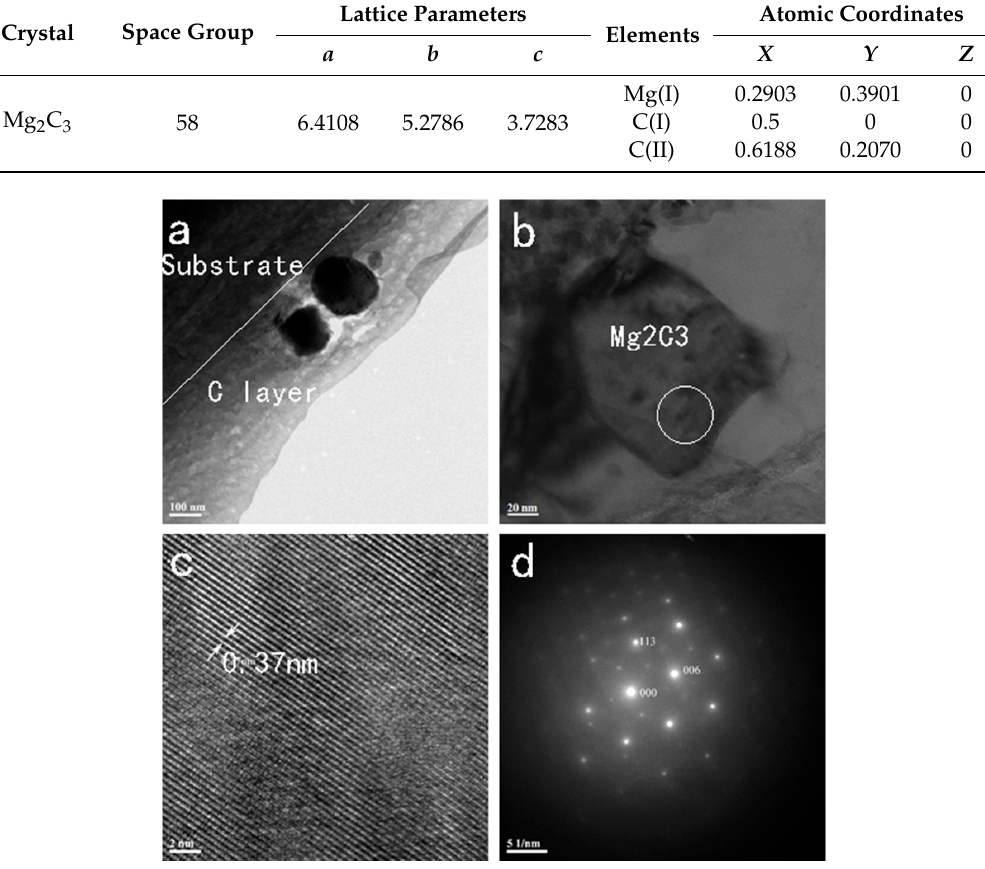
Table 2. Lattice parameters of Mg 2 C 3 .